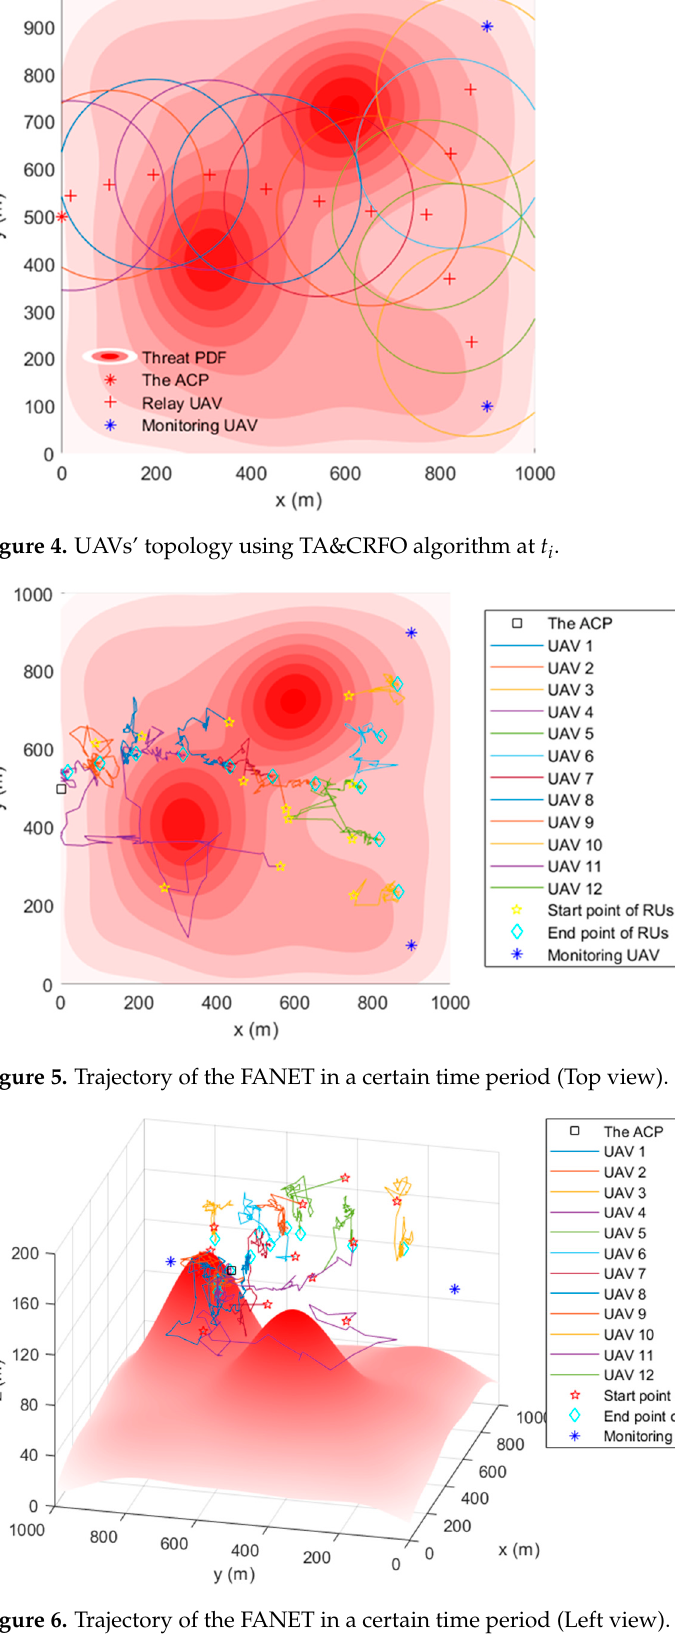
Figure 6. Trajectory of the FANET in a certain time period (Left view).